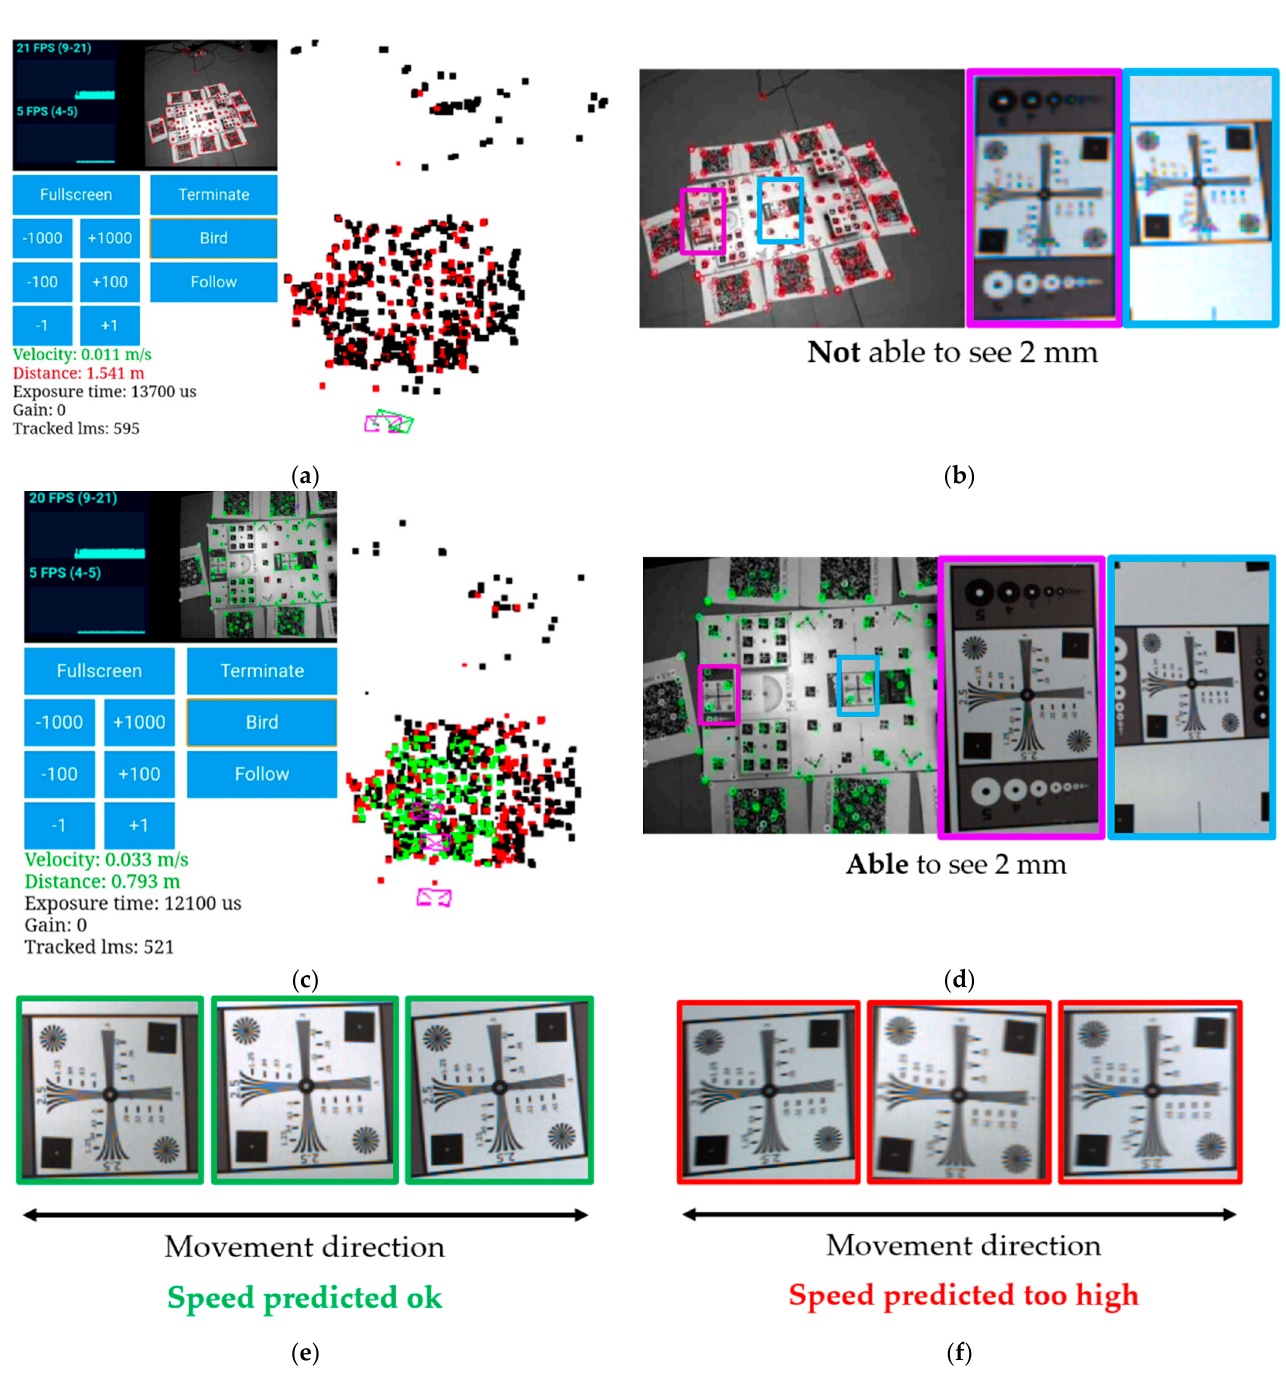
Figure 7. System interface and the positioning and speed feedback test( a – f ). See Section 3.2 for a detailed explanation.